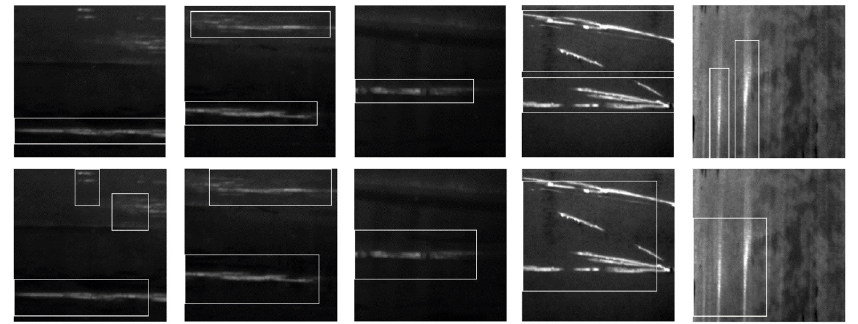
Figure 13. Five pairs of defect detection results of the proposed approach (NEU steel surface defect dataset [26]). Each pair of results consists of the ground truth bounding boxes ( top ) and detected bounding boxes ( bottom ). Table 1. The performance comparison (defect patch classifier) of various defect detection